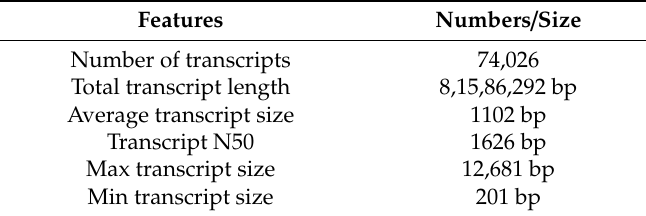
Table 2. Statistics of genome guided transcriptome assembly.